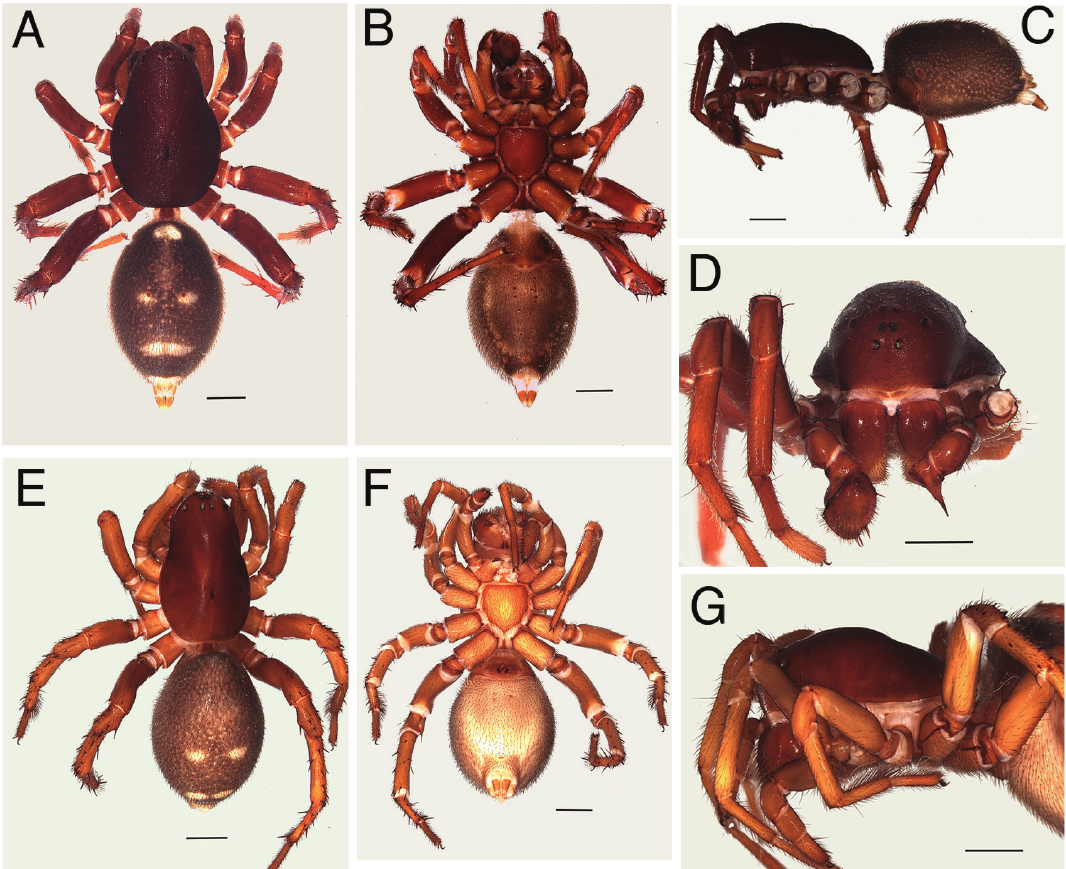
Fig. 3. Palindroma morogorom gen. et s p. nov. A–D. Paratype, ♂. E–G. Paratype, ♀. A . ♂, habitus, dorsal view. B . Idem, ventral view. C . Idem, lateral view. D . Idem, frontal view. E . ♀, habitus, dorsal view. F . Idem, ventral view. G . Idem, lateral view. Scale bars = 1